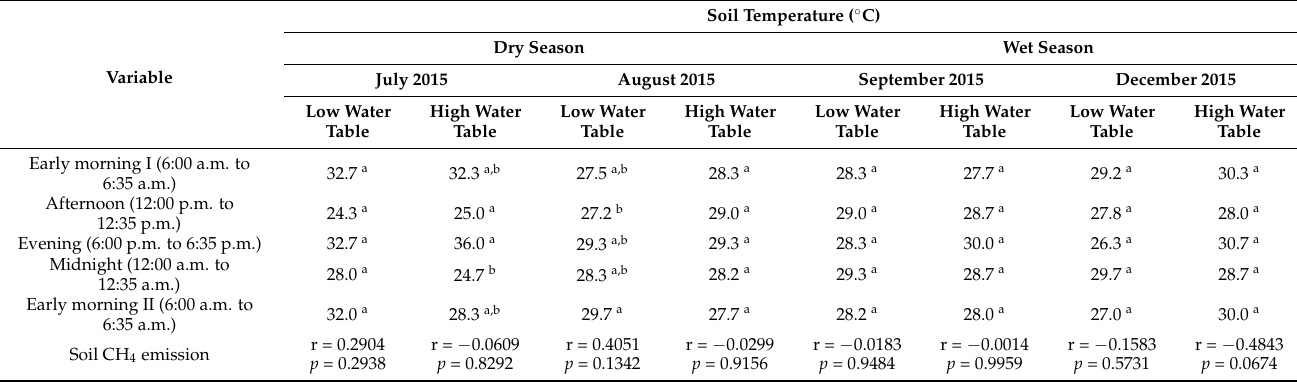
Table 2. Relationship between soil CH 4 emission and soil temperature from lysimeters cultivated with pineapples under simulated water table fluctuation throughout the dry and wet seasons in 2015.